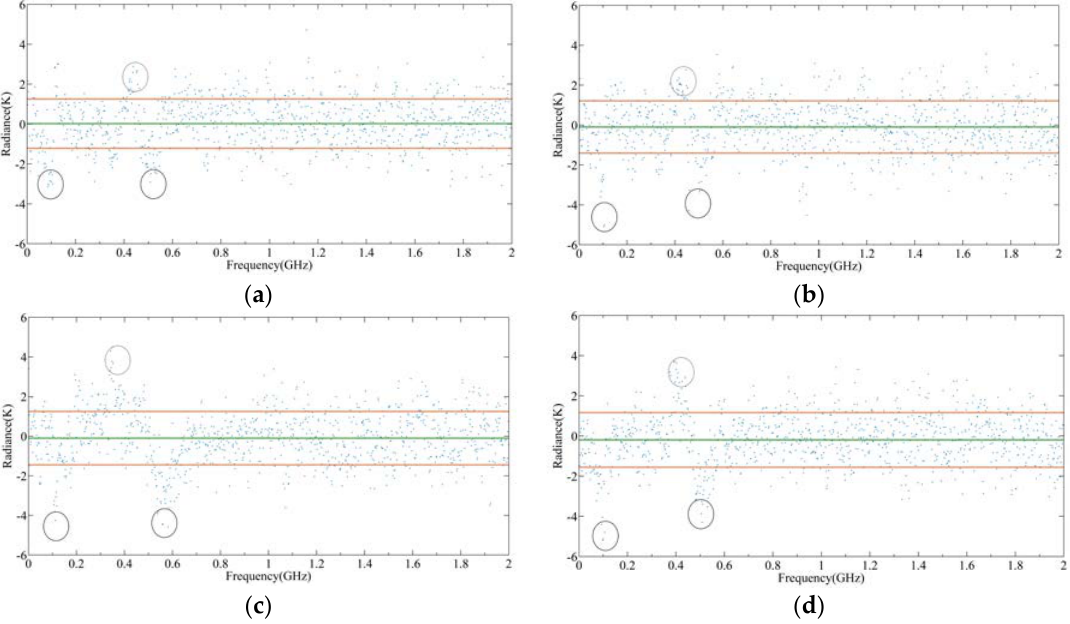
Figure 16. Simulation results of radiance error caused by the imbalance in 240 GHz S5: ( a ) Imbalance is 0.5%; ( b ) imbalance is 1%; ( c ) imbalance is 1.5%; ( d ) imbalance is 2%.